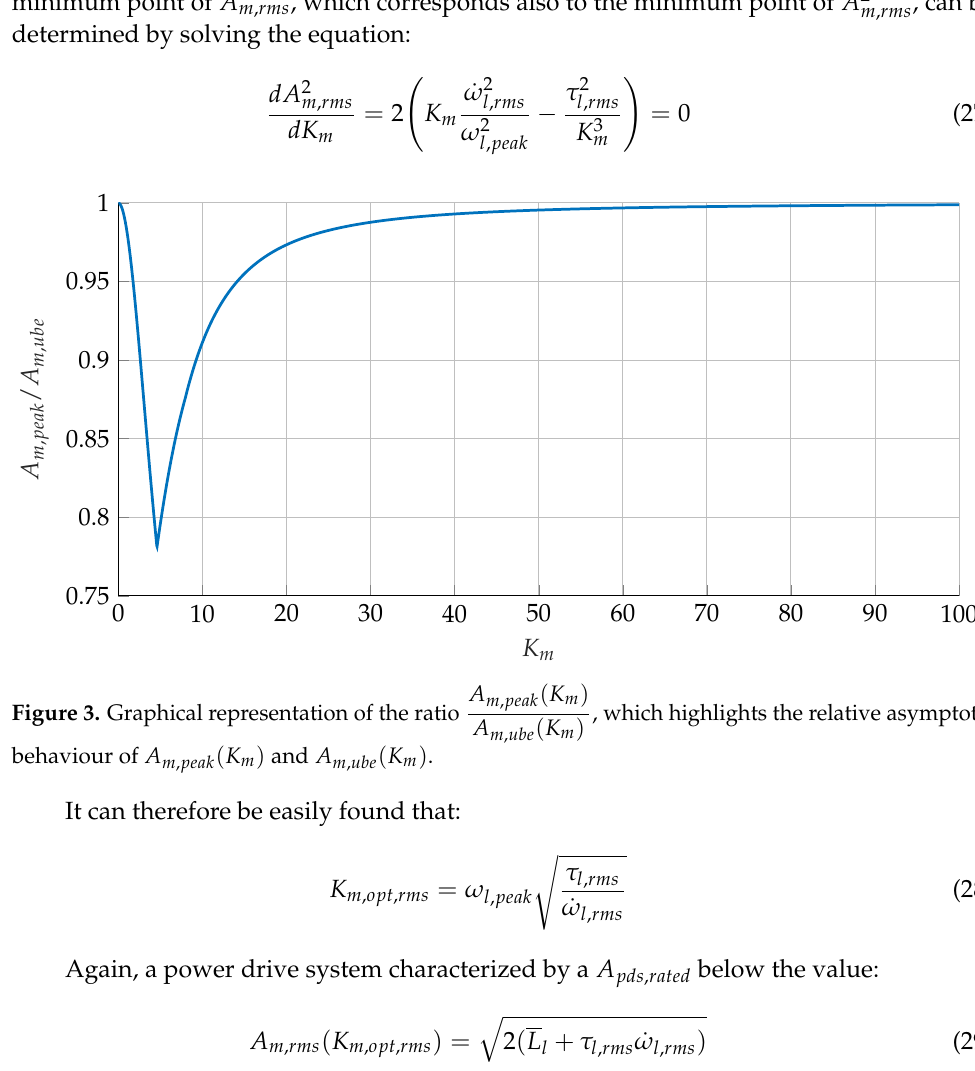
A m , peak ( K m ) , which highlights the relative asymptotic A m , ube ( K m )